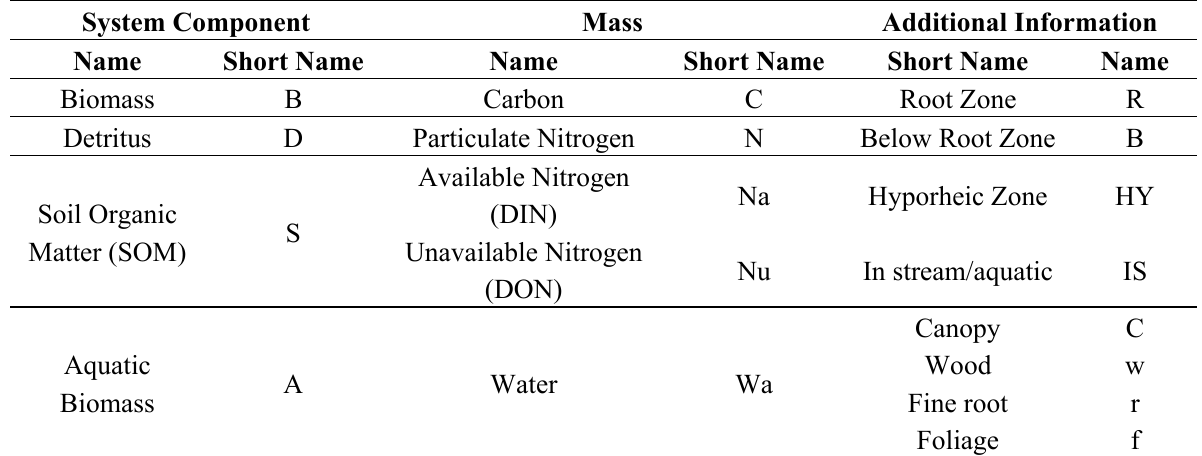
Table 1. Definition of naming convention used in the mathematical description of the model. Terms used in rate equations follow the form: Component Mass,Location .